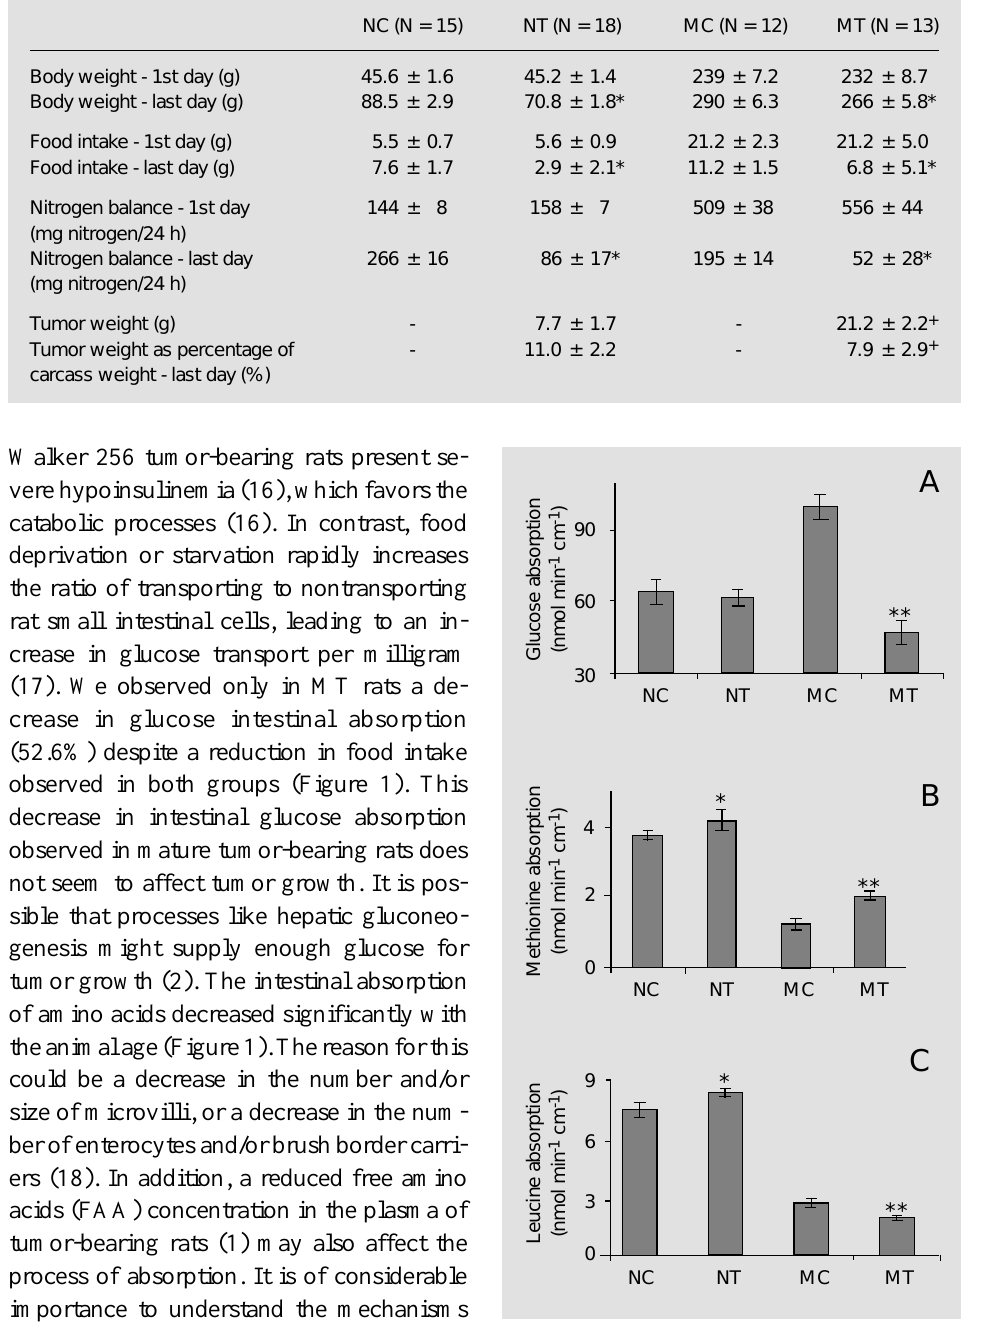
Table 1 - Effect of Walker 256 tumor growth on various parameters of newly weaned and mature rats. The results are reported as mean ± SEM. N = Number of rats. NC, Newly weaned controls; NT, newly weaned tumor-bearing rats; MC, mature controls; MT, mature tumor-bearing rats. *P<0.05 for comparison of NC or MC vs NT or MT. + P<0.05 for comparison between NT and MT. Parameters